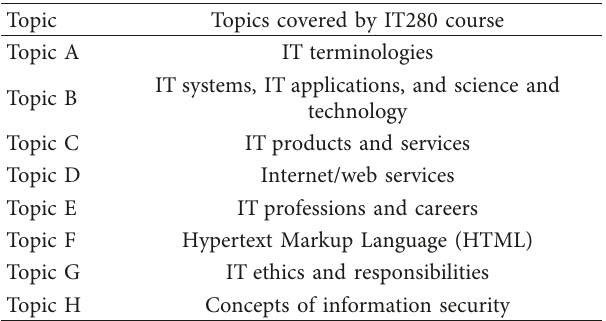
Table 1: Topics covered by IT280 course. Table 3: Entry number coded for each exam question.